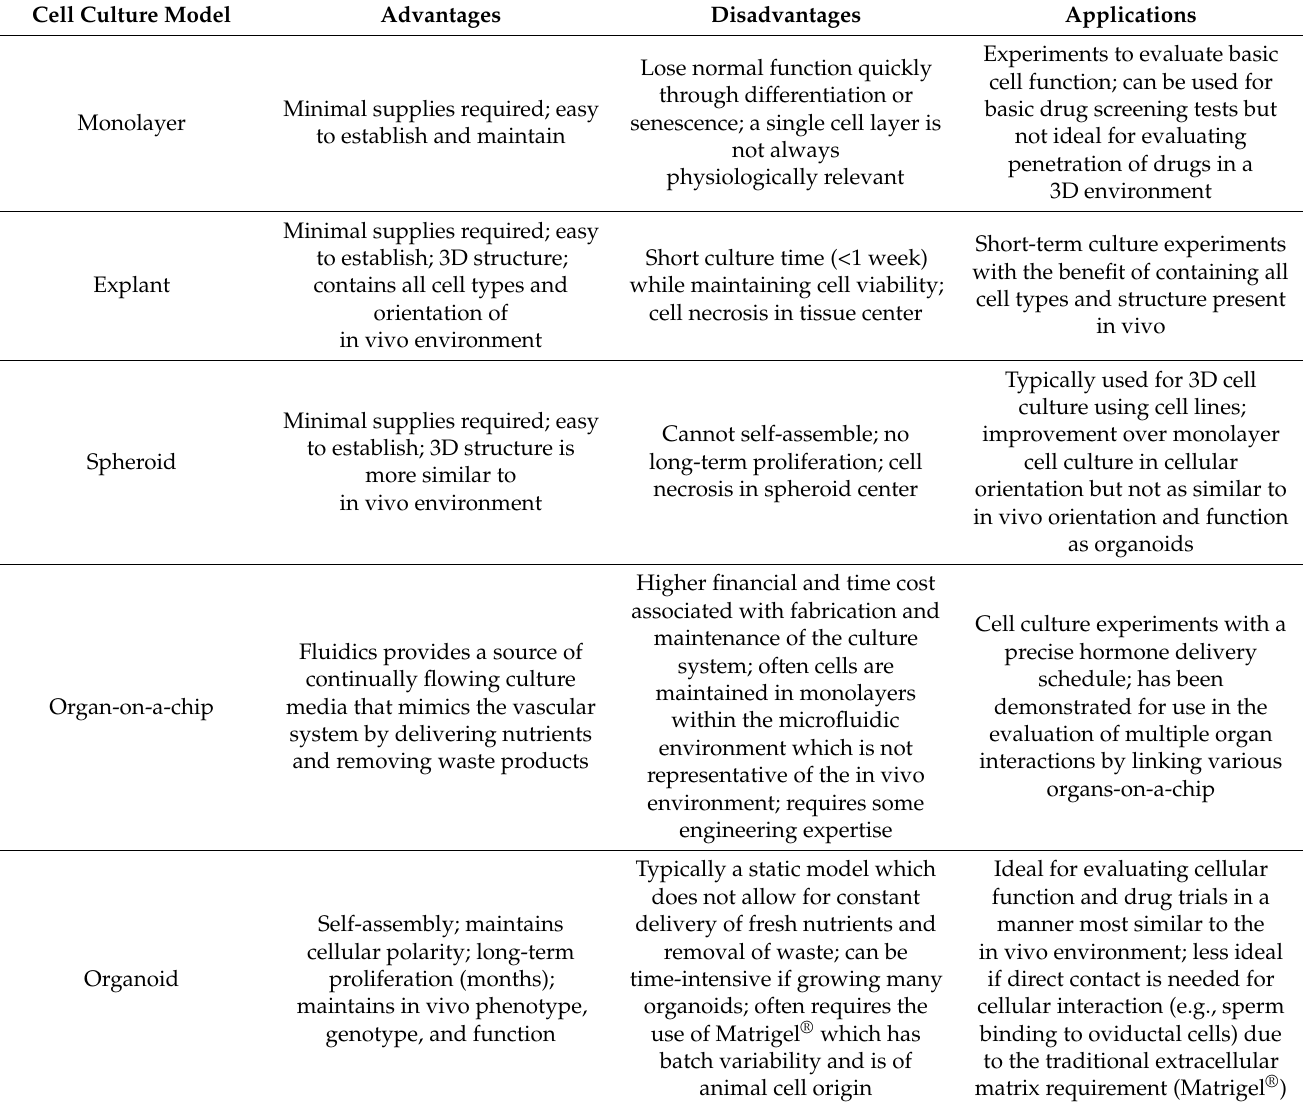
Table 1. Comparison of different in vitro